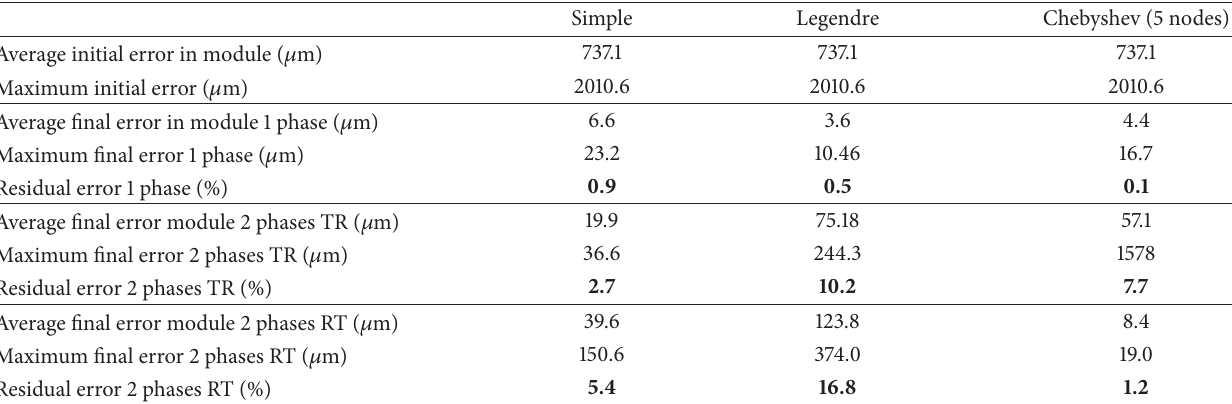
Table 8: Linear axes characterization.